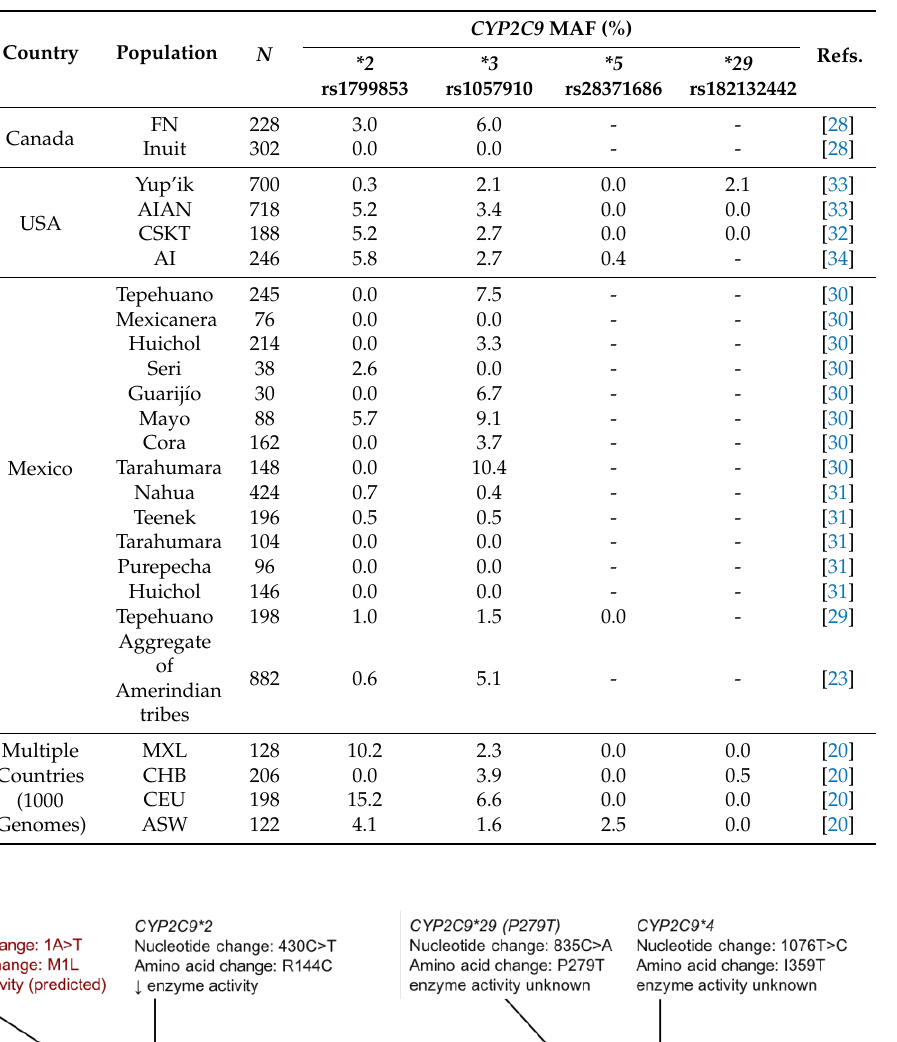
Table 6. Comparison of CYP2C9 allele frequencies in Indigenous North American populations to global populations from the 1000 Genomes Project [20]. N represents the number of alleles. Not shown in the table are CYP2C9*4 (rs56165425) and CYP2C9*6 (rs9332131), as these SNVs were either absent or not tested for in North American Indigenous populations. Global populations are abbreviated as follows: African Ancestry in Southwest US (ASW); Utah residents with Northern and Western European ancestry (CEU); Han Chinese in Beijing, China (CHB); Mexican Ancestry in Los Angeles, California (MXL).